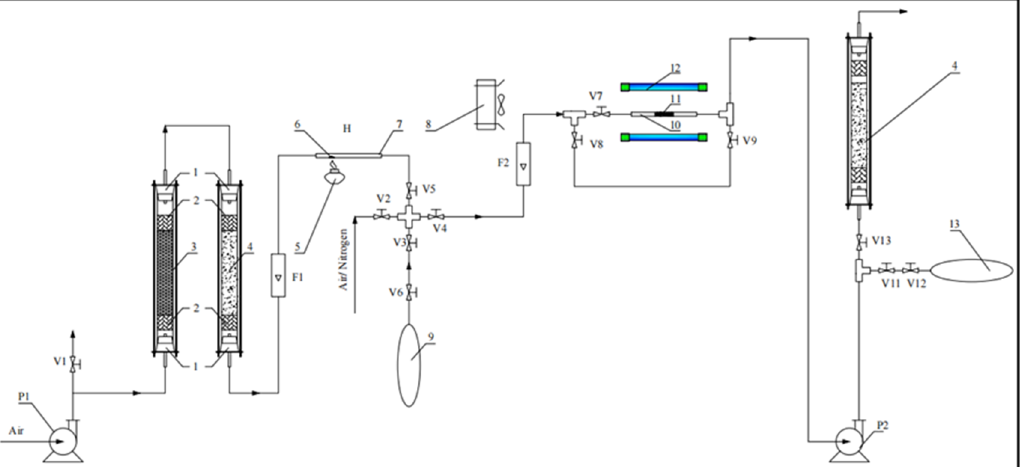
Figure 2. Schematic of toluene degradation system. 1. Rubber cap; 2. Glass wool; 3. Silica gel; 4. Activated carbon; 5. Alcohol burner; 6. Drops of toluene and water; 7. Quartz tube; 8. Cooling fan; 9. Bag containing inlet gas; 10. Reaction tube; 11. Photocatalyst; 12. UV light; 13. Bag containing outlet gas. P1: Compressor 1; P2: Compressor 2; F1: Flow meter for inlet gas; F2: Flow meter for gas passing through photocatalyst layer.